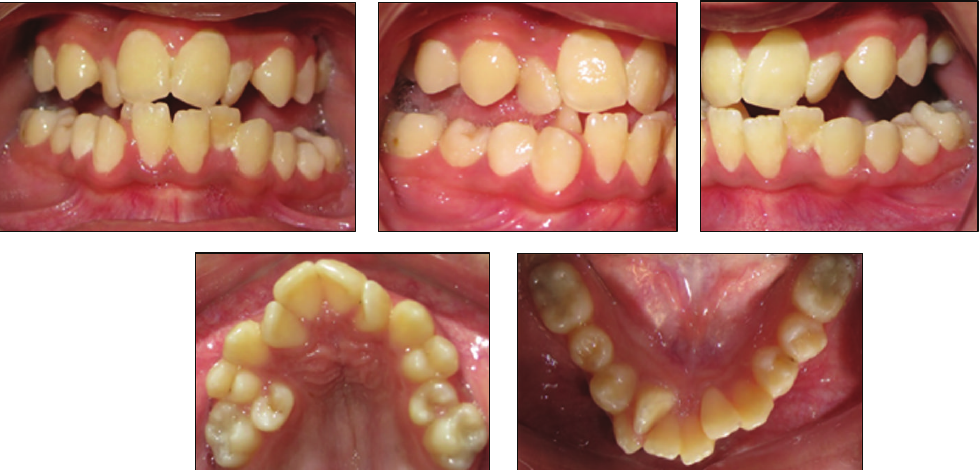
Figure 2: Intraoral features.